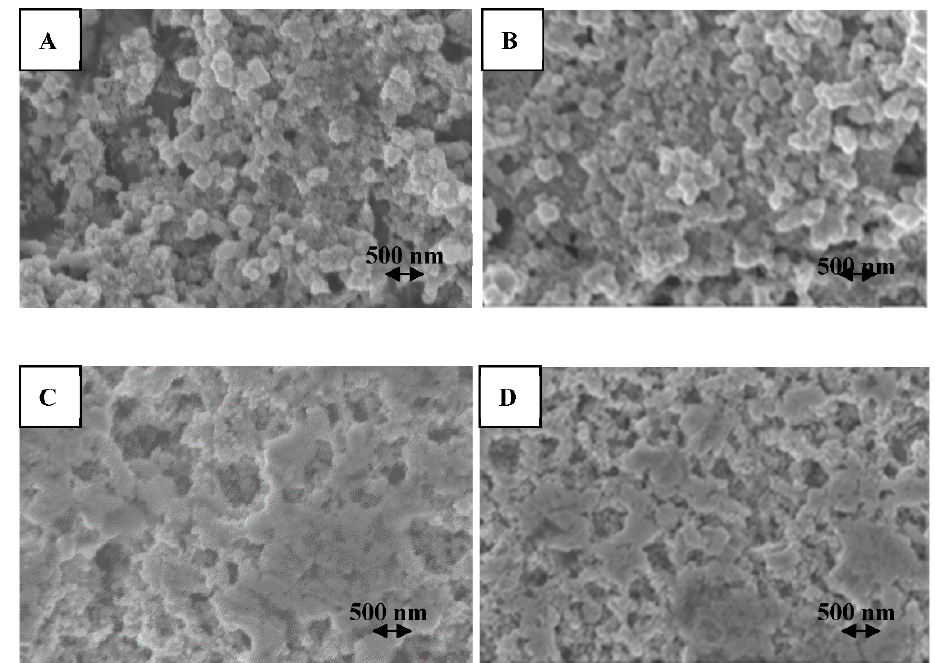
Figure 7. SEM images of metallic coatings of nanocomposite inks after drying at 60 °C: ( A ) doped with 0.5% and ( B ) doped with 1% of Ag NPs; after sintering: ( C ) doped with 0.5% (200 °C) and ( D ) doped with 1% of Ag NPs (150 °C). The drying process was performed for 15 min while sintering was performed for 30 min.